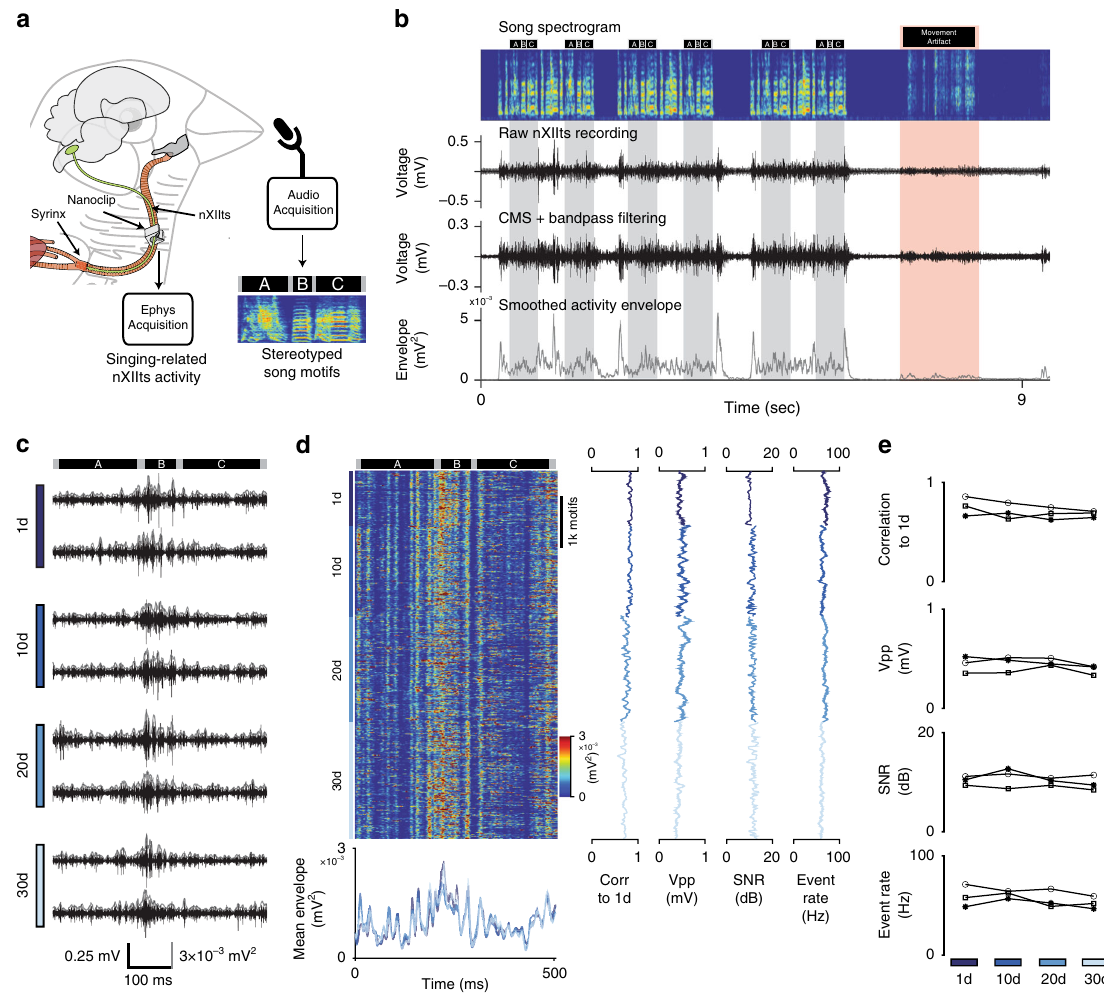
Fig. 4 Long-term stable recordings with minimal degradation over more than 4 weeks. a Schema for chronic recording of nXIIts activity in the singing bird. A nanoclip was implanted on the right-side nXIIts; song-triggered acquisition software captured both vocalization and concurrent nXIIts activity. Example song motif spectrogram from bird shown in ( b – d ); black bars above the spectrogram indicate the beginning and end of each syllable in the motif ( “ A, ” “ B, ” and “ C ” ). b Representative example of chronic nXIIts recording aligned to song. Top row: spectrogram of bird ’ s song containing three song bouts, each with two repeated motifs. Black bars above the spectrogram indicate song syllable boundaries; gray bands denote song motifs. Red band identi fi es movement-related noise and associated motion artifact in the electrophysiology recording. Second row: unprocessed nXIIts activity. Third row: nXIIts activity (from second row) after common-mode subtraction (CMS) and fi ltering. Bottom row: smoothed nXIIts activity envelope. c Representative nXIIts recordings from the bird are shown in ( b ) on days 1, 10, 20, and 30 post implant. Gray line shows the smoothed activity envelope for each recording. Dark bars at top indicate the recording alignment to syllables; bars at bottom indicate time, voltage, and signal envelope scale. d Stability of chronic recordings from the bird appearing in ( b , c ) over 30 days. Left-top: song-aligned nXIIts activity envelopes for motifs produced on days 1, 10, 20, and 30 post implant. Left-bottom: mean song-aligned activity envelope (over ten trials) recorded on days 1, 10, 20, and 30 post implant. Line colors indicate recording day. Middle left: running correlation between the song-aligned nXIIts activity envelope and the mean day 1 activity envelope. Middle: running peak-to-peak voltage during singing. Middle right: running SNR of recordings during singing. Far-right: Running estimated event rates during singing. e Summary data of chronic recordings over 30 days in n = 3 birds; symbols identify individual birds. Top: mean daily trial-by-trial Pearson ’ s correlation to the average activity pattern on the 1st day of singing. Middle-top: mean daily peak-to-peak voltage. Middle-bottom: mean daily SNR of nXIIts recordings. Bottom: mean daily event rates. Source data are provided as a Source Data envelopes and the mean activity envelope on day 1, (2) the Vpp of singing-related activity, (3) the SNR of singing-related activity, and (4) the event rate of singing-related activity (Fig. 4d, right). Across n = 3 birds, we found no signi fi cant differences in the daily means of these stability metrics between day 1 and any subsequent day (correlation: P > 0.089; Vpp: P > 0.156; SNR: P > 0.208; event rate: P > 0.147; Fig. 4e). These analyses demonstrat- ing stable longitudinal recordings of nXIIts activity suggest that (Fig. 4a), the nanoclip implant site is ~5 – 10 mm from the nearest the nanoclip is well-suited to mapping PNS function at chronic timescales.